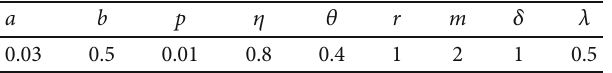
Table 1: Parameters of the insurance market and the geometric Brownian